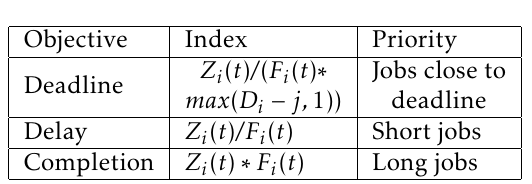
Table 1. Summary of different objectives and index